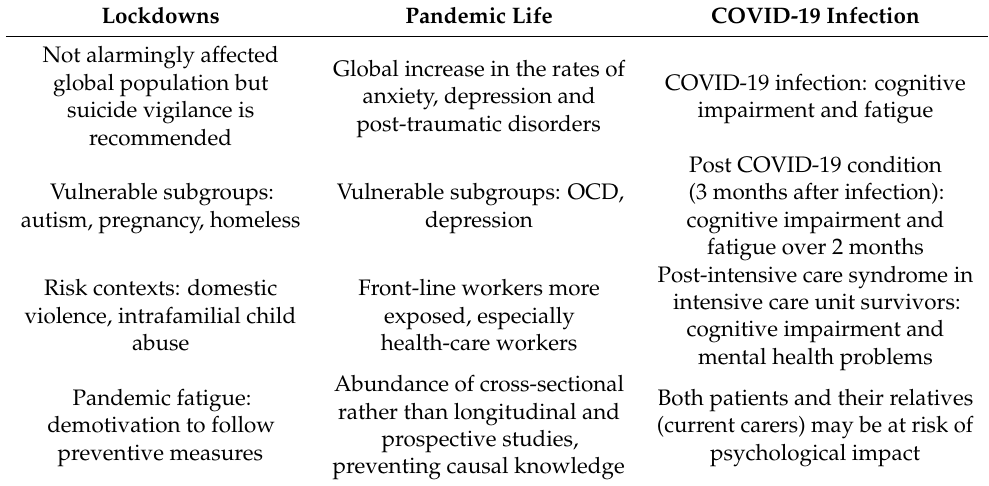
Table 1. Brief summary of sources and symptoms of psychological impact related to